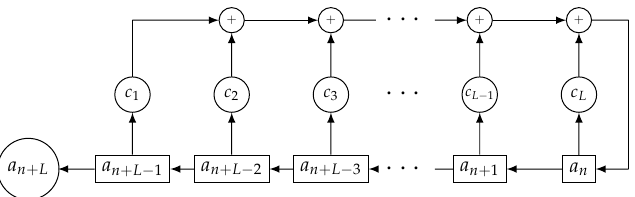
Figure 1. A scheme of LFSR with L